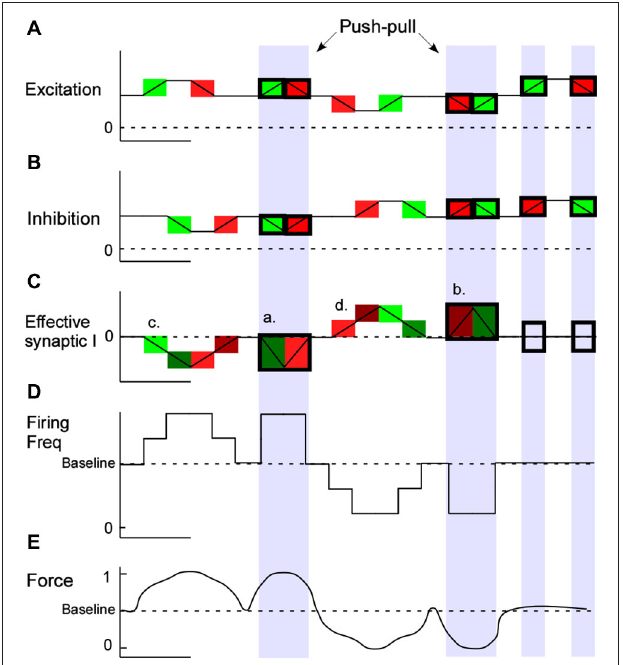
FIGURE 4 | Push-pull combinations and outcomes . Modulating excitation and inhibition from a tonic background of each conductance should allow for greater output gain. Combinations of excitatory and inhibitory input coupling and the predicted impact on motoneuron firing and muscle force production are illustrated. In this basic model as excitatory (A) and inhibitory (B) condudtances occur in the dendrites the effective synaptic current at the motoneuron soma is illustrated in green (net depolarizing) and red (net hyperpolarizing) (C) . Motoneuron firing frequency changes are illustrated in (D) and muscle force production (E) . During concomitant conductance changes, push-pull effects are seen (shaded blue).